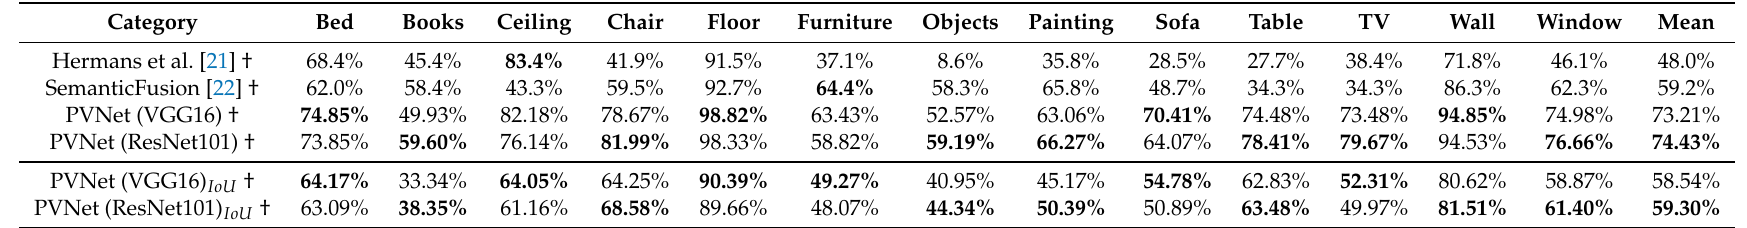
Table 4. Comparison of the class-wise accuracy on the NYU V2 dataset. Some of the methods in Table 2 do not provide the class-wise accuracy; hence, they are omitted here. The class-wise IoU of the Pixel-Voxel network (PVNet) are also provided. The methods with † take advantage of the data from multiple views. The best performance among the compared methods is marked as